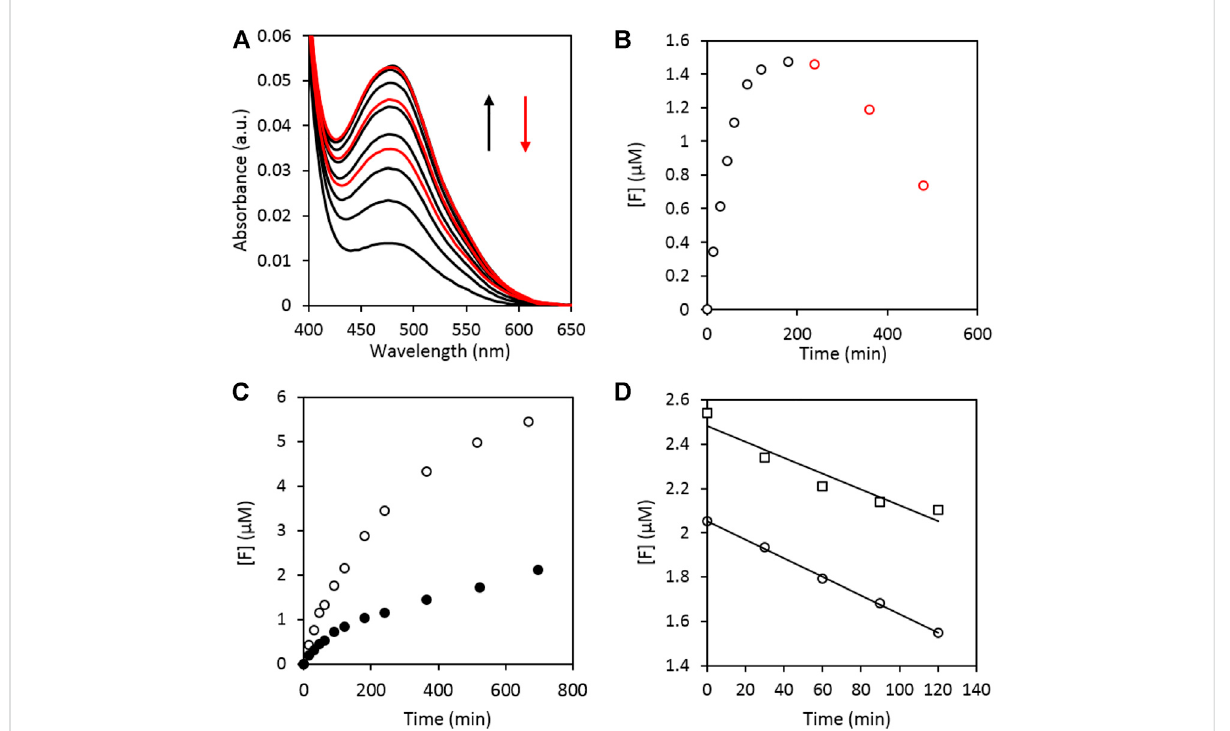
FIGURE 2 A) UV-VIS absorption spectra of the illuminated reaction mixture taken at different time intervals showing the formation of XTT formazan with λ fi rst 180 min of illumination (black curves) after which the absorption band starts to decrease max at 480 nm. The absorbance increases during the again (red curves). (B) Time dependent change of the formazan concentration ([F]) of (A) . The values were corrected for the initial conversion occurring during sample preparation. (C) Difference in formazan production between an illuminated (open data points) and dark ( fi lled data points) sample. (D) Zero order discoloration of the formed formazan illuminated at 81 mW cm − 2 [ ○ , R 2 = 0.994, slope = (4.18 ± 0.08) nM min − 1 ]